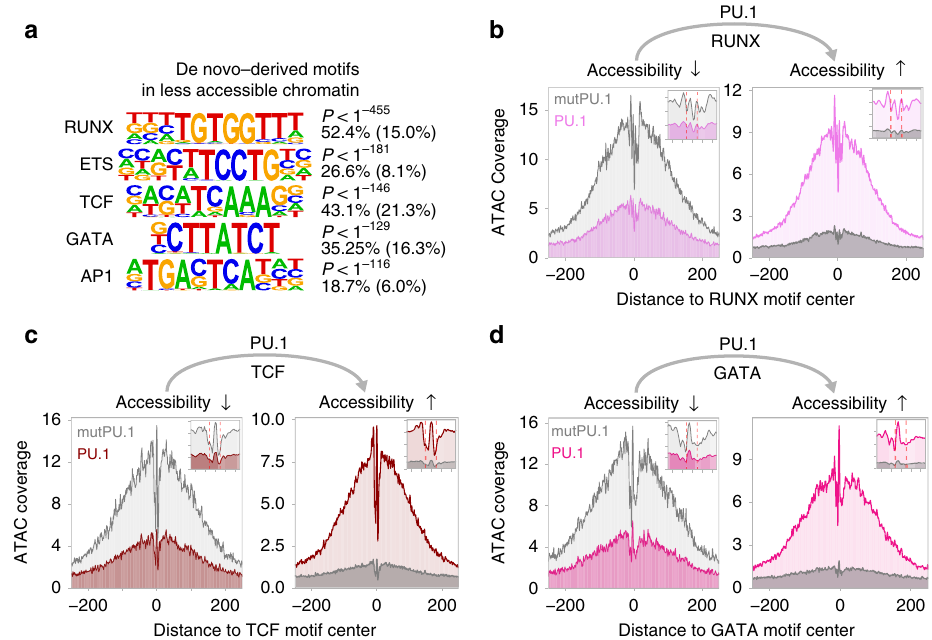
Fig. 5 Motif signatures at sites loosing accessibility. a De novo-derived motifs enriched across regions that lost accessibility upon PU.1 induction in CTV-1 cells. The best motifs corresponding to known factor families derived from individual clusters are shown. The signi fi cance of motif enrichment (hypergeometric test) and the fraction of motifs in peaks (background values are in parenthesis) are given for the top fi ve motifs corresponding to known motif families. b – d Representative ATAC-seq footprints across enriched motif-centered peaks that either lost or gained accessibility upon PU.1 induction in CTV-1 cells. Footprints of control cells (mutPU.1) are in grey, footprints of PU.1 mRNA-transfected cells are colored. Smaller histograms in the upper right corner zoom into the central part of the main graph. The position of the PU.1 motif is indicated by two vertical dashed lines. a – d Source data are provided as a Source Data fi